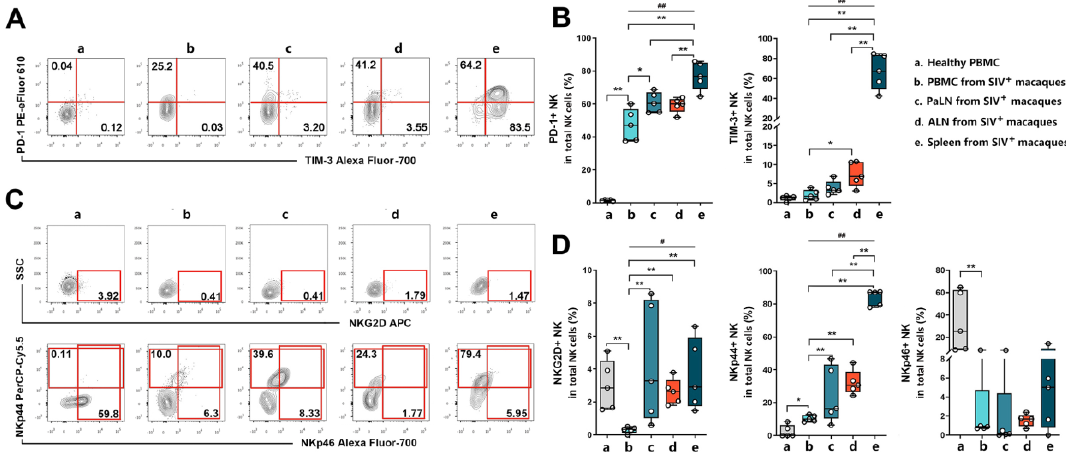
Figure 3. Expression of PD-1, Tim-3, and NK cells receptors on simian NK cells from healthy and SIV-infected macaques. ( A ) and ( C ) are representative cytofluorometric plots for one healthy macaque (a) and SIV-infected macaques (b, c, d, e). Representation of groups a, b, c, d, and e were on the top right corner. Group a was PBMC form healthy macaques; Group b, c, d, e, respectively represented PBMC, PaLN, ALN, spleen from SIV-infected macaques. ( A ) Representative cytofluorometric analysis of PD-1 and Tim-3 expression on simian NK cells. NK cells were gated according to the lymphocyte forward and side scatter pattern and then CD3 − CD8 α + NKG2A + cells were gated to analyze PD-1 and Tim-3 expression. ( B ) Box-plot analysis for the frequencies of PD-1 + and Tim-3 + NK cells. Lines represent median values, boxes show the 25th and 75th percentiles, and bars show minimum and maximum values. As the data did not obey a normal distribution, after comparing multiple group differences using the Kruskal–Wallis test, the Mann–Whitney U test was performed to compare differences between the two groups. “#” indicates significant differences using the Kruskal–Wallis test (#, p < 0.05; ##, p < 0.01). “*” indicates significant differences by Mann–Whitney U test (*, p < 0.05; **, p < 0.01). ( C ) Representative flow cytometric plots indicating expressions of NKG2D, NKp44 and NKp46 on simian NK cells. NK cells were gated according to the lymphocyte forward and side scatter pattern and then CD3 − CD8 α + NKG2A + cells were gated for analysis. ( D ) Box-plot analysis for the frequencies of NKG2D + , NKp44 + , and NKp46 + NK cells. Lines represent median values, boxes show the 25th and 75th percentiles, and bars show minimum and maximum values. As the data did not obey a normal distribution, after comparing multiple group differences using the Kruskal–Wallis test, the Mann–Whitney U test was performed to compare differences between the two groups. “#” indicates significant differences using the Kruskal–Wallis test (#, p < 0.05; ##, p < 0.01). “*” indicates significant differences by Mann–Whitney U test (*, p < 0.05; **, p < 0.01). PBMC—peripheral blood mononuclear cell; PaLN—paracolonic lymph node; ALN—axillary lymph